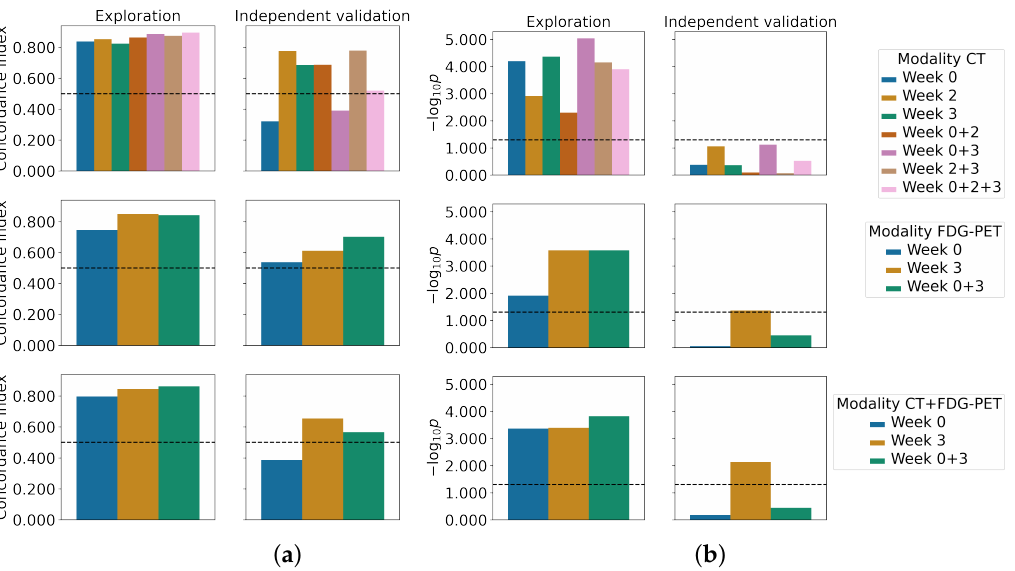
Figure 2. Performance of the final signature models in terms of discrimination ( left ) and stratification ( right ) are shown for both the exploratory cohort and independent validation cohort. The final signature was determined from the MRMR feature importance scores of all bootstraps from the cross-validation. Values above the dashed line indicate non-random predictions and statistically significant stratifications, respectively: ( a ) concordance index; ( b ) log-rank p -value, log